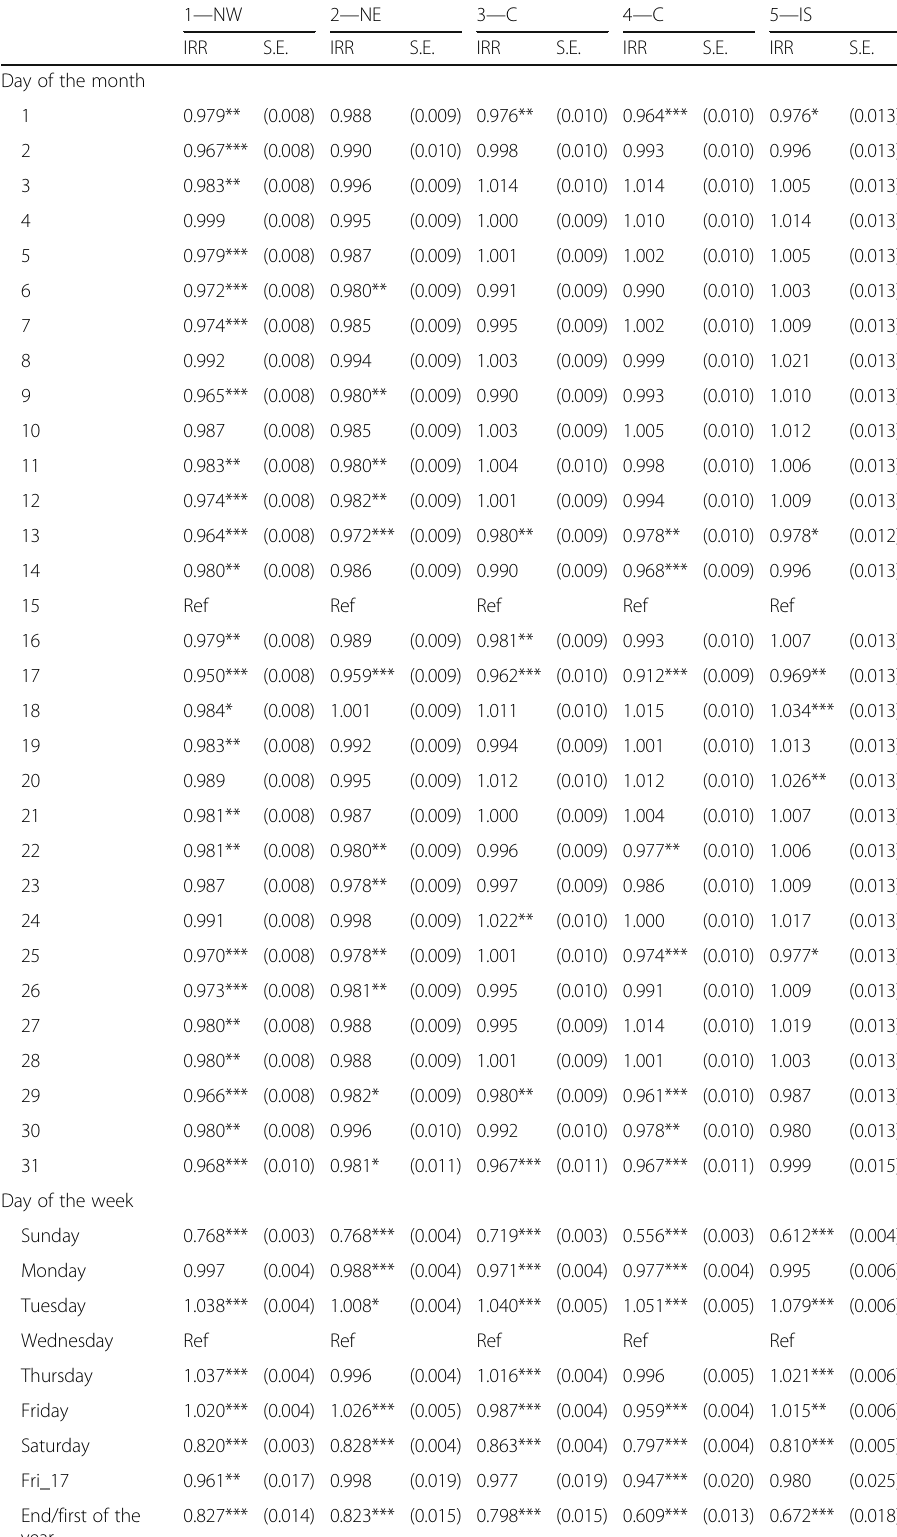
Table 3 The calendar effect on the daily female births in Italian macro-areas from 1 January 1999 to 30 June